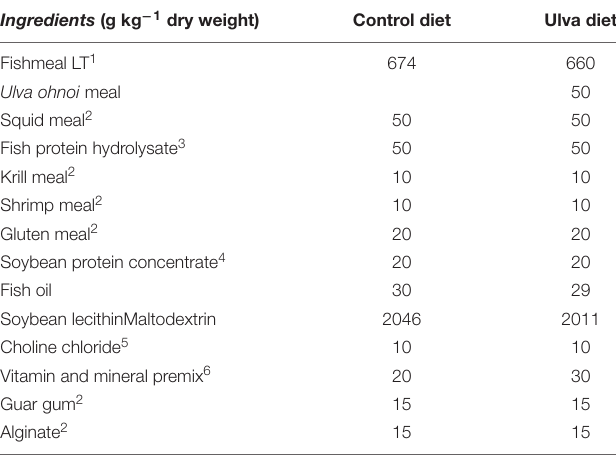
TABLE 1 | Ingredient composition of the experimental diets used in the feeding